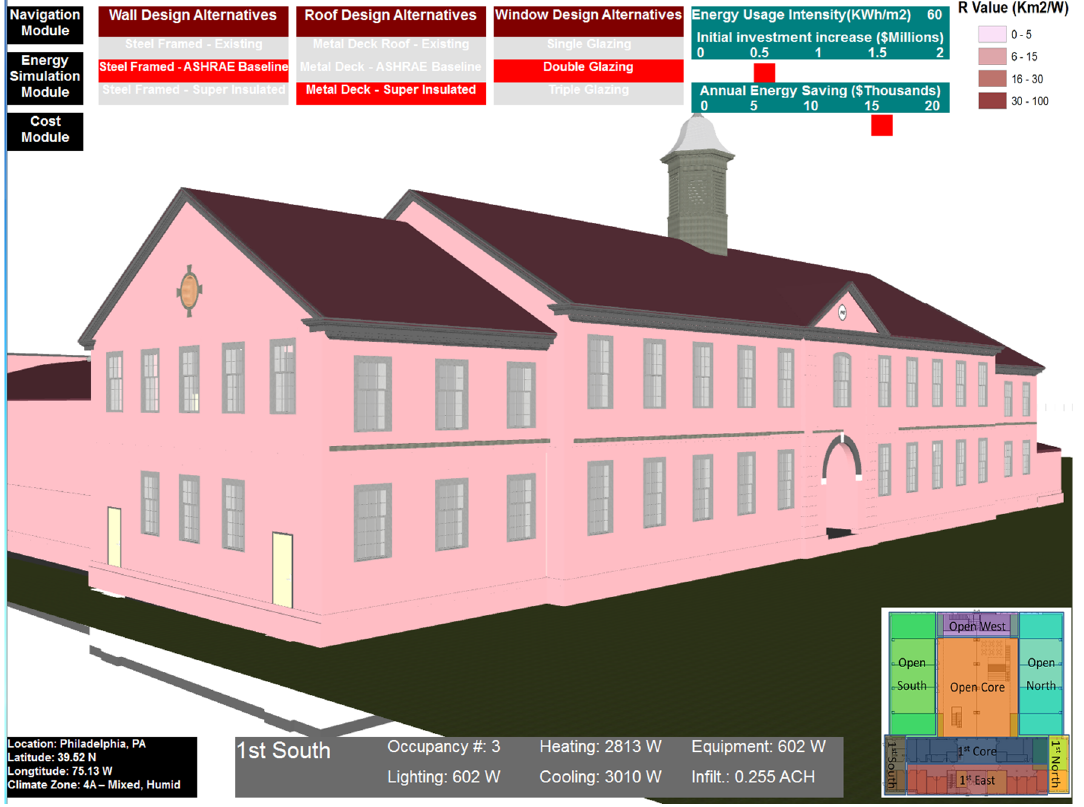
Figure 3. A snapshot from the virtual world while a user is in energy simulation